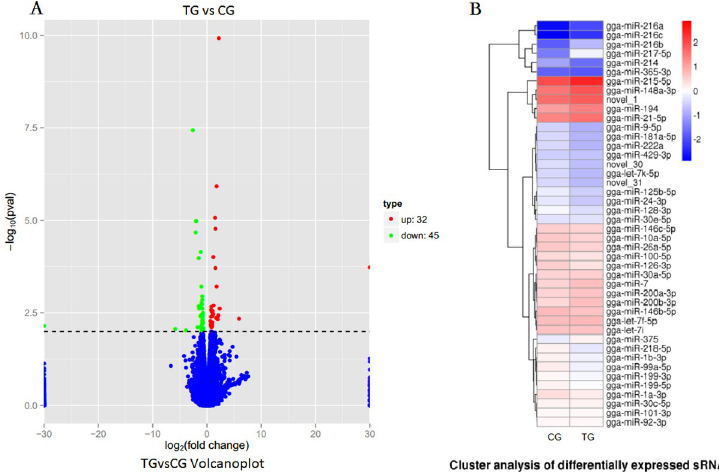
Fig 2. Heatmap of differentially expressed genes and differentially expressed miRNAs in the CG and TG intestine. (A) Heatmap of differentially expressed genes in the TG compared with the CG. (B) Differentially expressed miRNAs in the TG compared with the